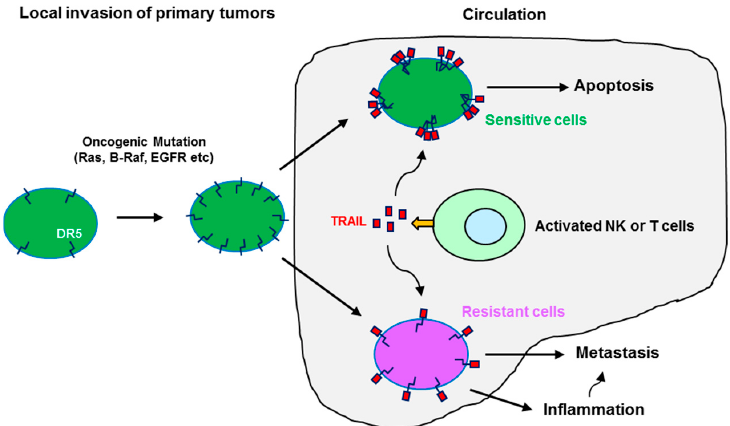
Figure 3. A schematic illustration of the potential impact of oncogenic Ras and Raf mutation-induced DR5 expression on apoptosis and metastasis of cancer cells. While the majority of Ras or Raf mutant cancer cells with elevated DR5 in the circulation will be eliminated by activated immune cells such as NK and T cells that produce TRAIL, triggering TRAIL/DR5-mediated apoptosis through ligation with cell surface death receptors (e.g., DR5) of cancer cells, a subset of TRAIL/DR5- resistant cells with elevated DR5 may survive from escaping the immune surveillance in circulation to eventually form metastases; the elevated DR5 here may favor the formation of metastasis-related signaling complexes such as the FADDosome and enhancement of inflammation and cancer cell invasion and metastasis.